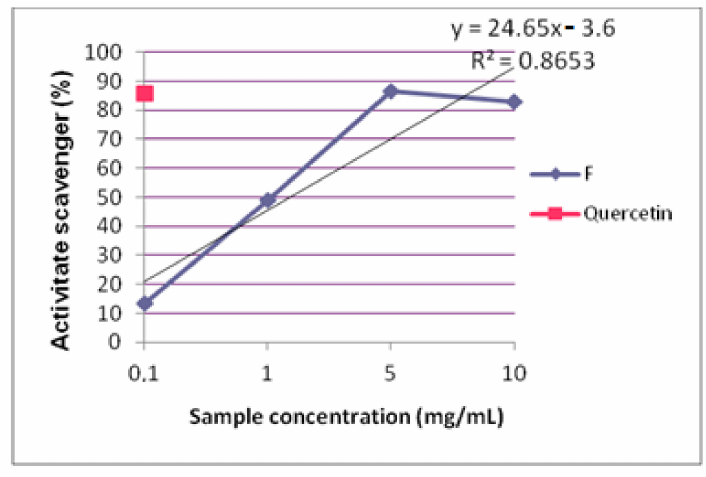
Figure 5. Scavenging activity of formula